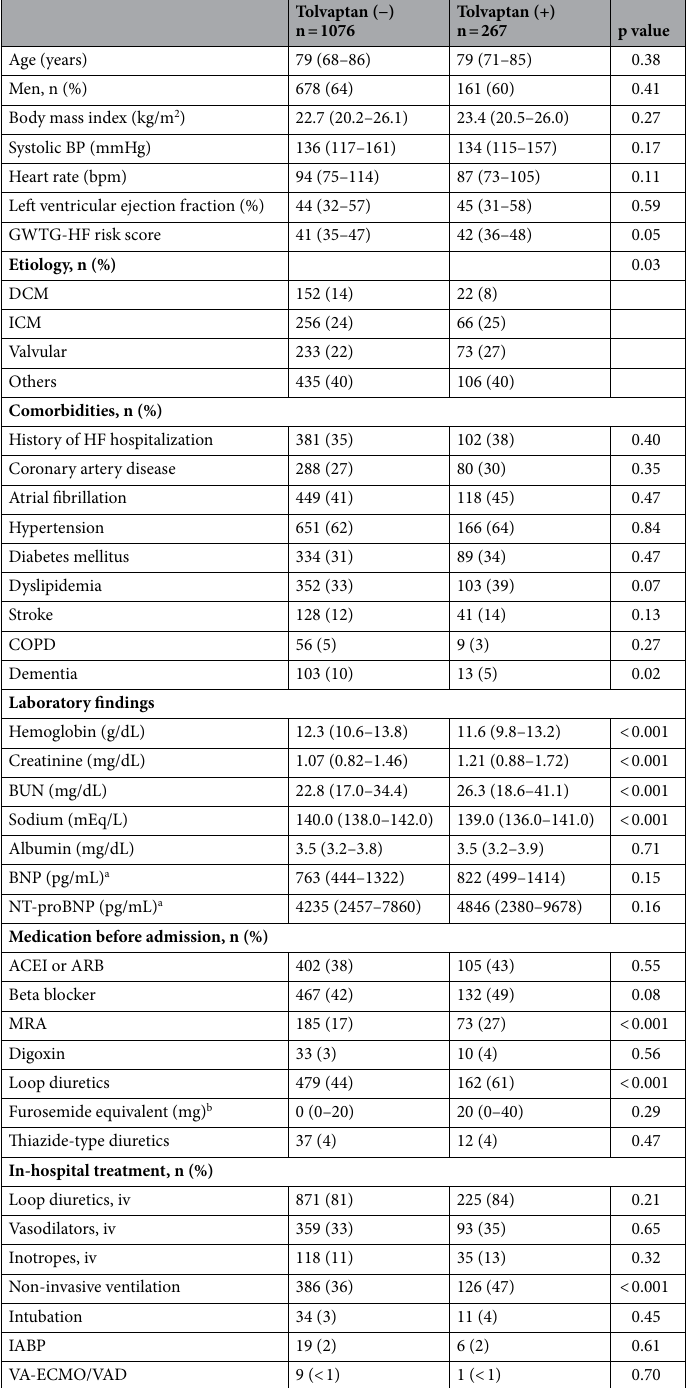
Table 1. Baseline characteristics. BP blood pressure, DCM dilated cardiomyopathy, ICM ischemic cardiomyopathy, HF heart failure, COPD chronic obstructive pulmonary disease, eGFR estimated glomerular MRA mineralocorticoid receptor antagonist, IABP intraaortic balloon pumping, VA-ECMO veno-arterial extracorporeal membrane oxygenation, VAD ventricular assist device. a In the 959 patients, BNP levels were measured, in contrast, NT-proBNP levels were measured in 384 patients. b Furosemide 20 mg = Azosemide 30 mg = Torsemide 4